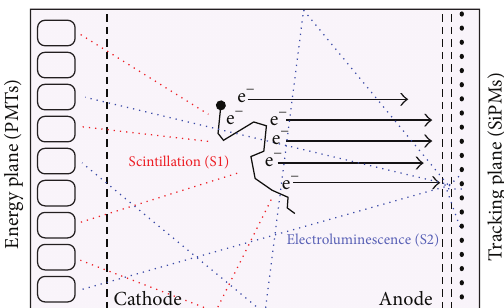
Figure 7: The Separate, Optimized Functions (SOFT) concept in the NEXT experiment: EL light generated at the anode is recorded in the photosensor plane right behind it and used for tracking; it is also recorded in the photosensor plane behind the transparent cathode and used for a precise energy measurement.